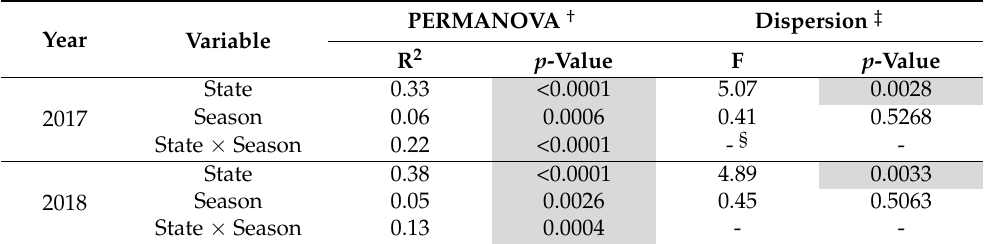
Figure 2. PCoA plots showing bacterial community beta diversity as a function of state and season in the 2017 ( a ) and 2018 soil samples ( b ). Sampling seasons are color coded, while the five states are indicated by different shapes. Ellipse shows the t-distribution of the season samples. Table 3. PERMANOVA and dispersion analyses of bacterial beta diversity in soil samples collected from the five states during early summer and late fall of each year.